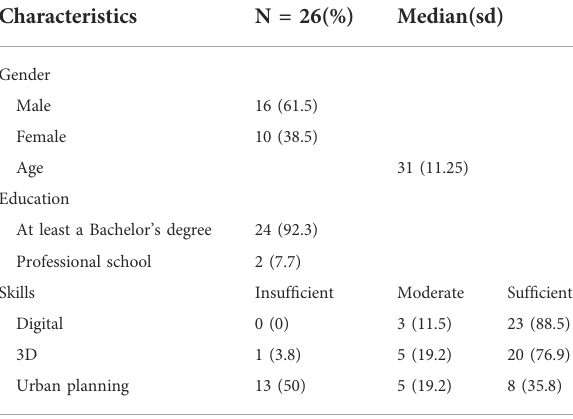
TABLE 1 Distribution of the socio-demographic characteristics of the 26 participants.